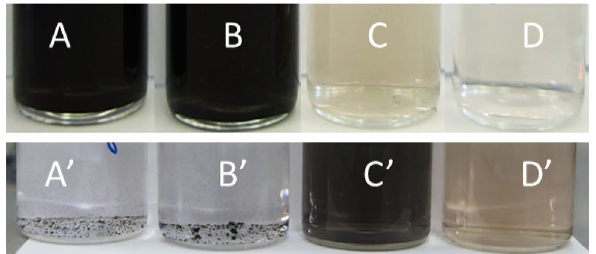
Figure 5. Photographical depiction of the reaction mixtures obtained after reduction in the batch ( A – D ), t = 60 min, T ≈ 100 °C and microwave autoclave reactor ( A ′ – D ′ ), t = 10 min, T max ≈ 225 °C; chemical composition of the reaction mixture: ( A , A ′ ) [Pt(IV)] = 5 × 10 −4 M, ( B , B ′ ) [Pt(IV)] = 2.5 × 10 −4 M, ( C , C ′ )